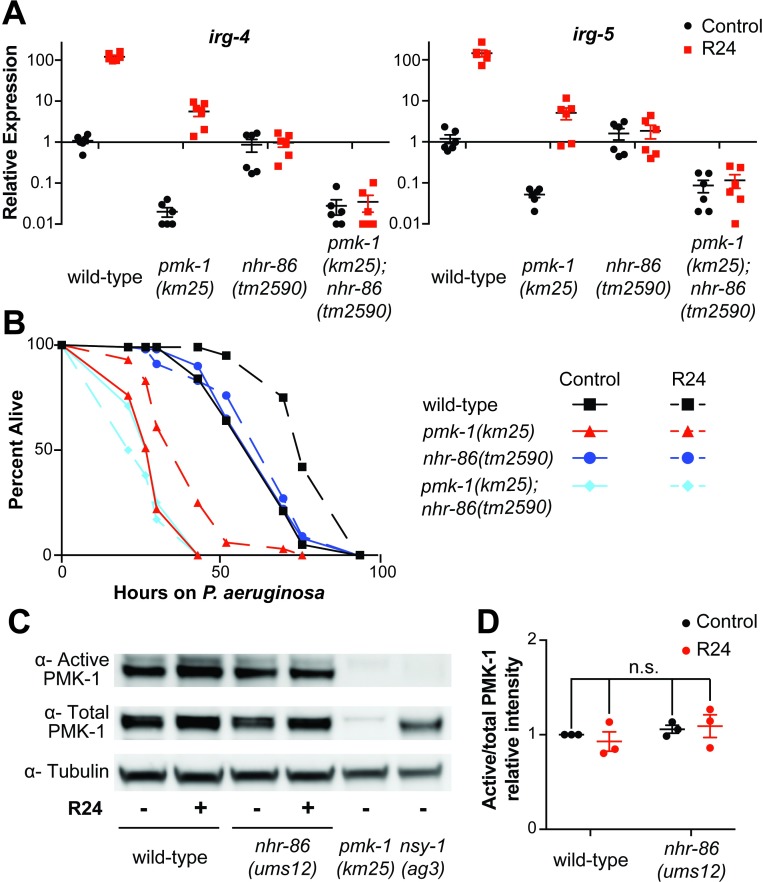
nhr-86 induces innate immune defenses independent of the p38 MAPK pmk-1.(A) The expression of the C. elegans immune effector genes irg-4, irg-5, drd-50, mul-1 and irg-6 were analyzed by qRT-PCR in wild-type animals, pmk-1(km25), nhr-86(tm2590), and pmk-1(km25); nhr-86(tm2590) double mutants, each exposed to either R24 or the control for approximately 18 hours. Data for drd-50, mul-1 and irg-6 are shown in S5A Fig. Data are the average of six independent replicates, each normalized to a control gene with error bars representing SEM. Data are presented as the value relative to the average expression from all replicates of the indicated gene in the baseline condition (wild-type animals exposed to control). The difference in induction of irg-4, irg-5, drd-50, mul-1 and irg-6 by R24 in wild-type animals compared to each of the mutant strains is significant (p<0.0001 by 2-way ANOVA with Bonferroni multiple comparisons test). There is no significant difference between the expression of these genes in pmk-1(km25) animals exposed to control compared to either condition in the pmk-1(km25); nhr-86(tm2590). (B)
P. aeruginosa infection assays of C. elegans wild-type, pmk-1(km25), nhr-86(tm2590), and pmk-1(km25); nhr-86(tm2590), each exposed to control or R24, are shown. The difference in susceptibility to P. aeruginosa between control and R24-exposed wild-type and pmk-1(km25) animals is significant (p<0.001). There is no significant difference between control and R24-exposed nhr-86(tm2590) and pmk-1(km25); nhr-86(tm2590) animals. Data are representative of three trials. Sample sizes, mean lifespan, % lifespan extension conferred by R24 treatment in each background and p values for all trials are shown in S4B Table. Significance was determined using Kaplan-Meier survival curves and log-rank tests. (C) Immunoblot analysis of lysates from L4 stage animals of the indicated genotype using antibodies that recognize the doubly-phosphorylated TGY motif of PMK-1 (⍺-Active PMK-1), the total PMK-1 protein (⍺-Total PMK-1) and tubulin (⍺-Tubulin). The total PMK-1 antibody detects total, but not active (phosphorylated) PMK-1. (D) The relative intensity of active PMK-1 and total PMK-1 was quantified from three biological replicates and is expressed as the average ratio of active to total PMK-1, relative to wild-type control. Error bars report SEM. There is no significant difference (n.s.) between these conditions (2-way ANOVA with Bonferroni multiple comparisons test).